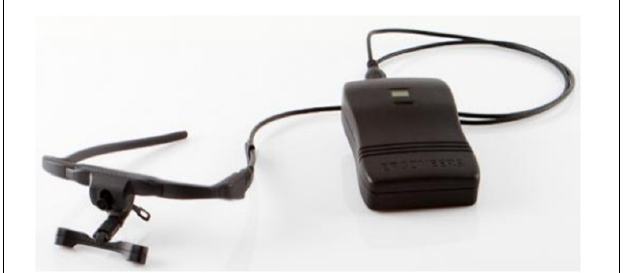
FIGURE 2 | Dikablis Glasses.